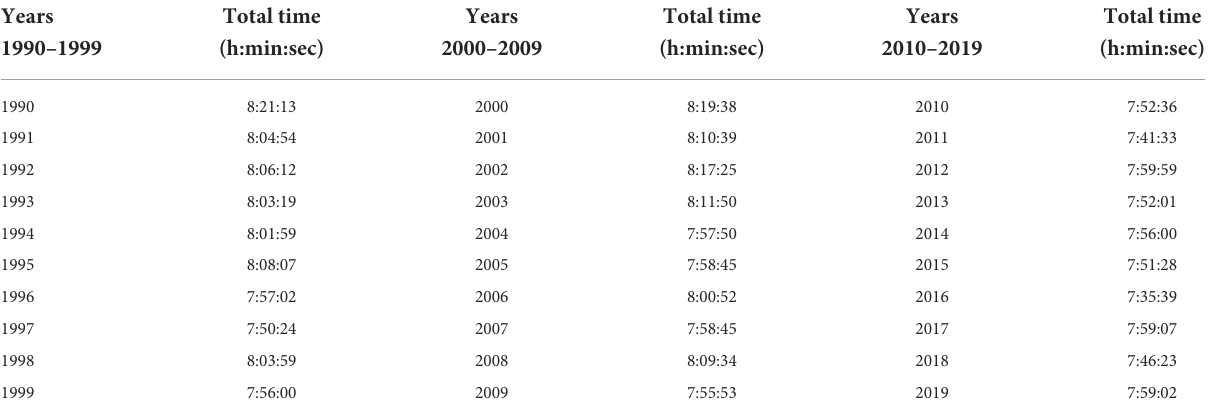
TABLE 2 Evolution of the racing time of the winners of the Challenge Roth Ironman TM triathlon from 1990 to 2019. Years Total time Years Total